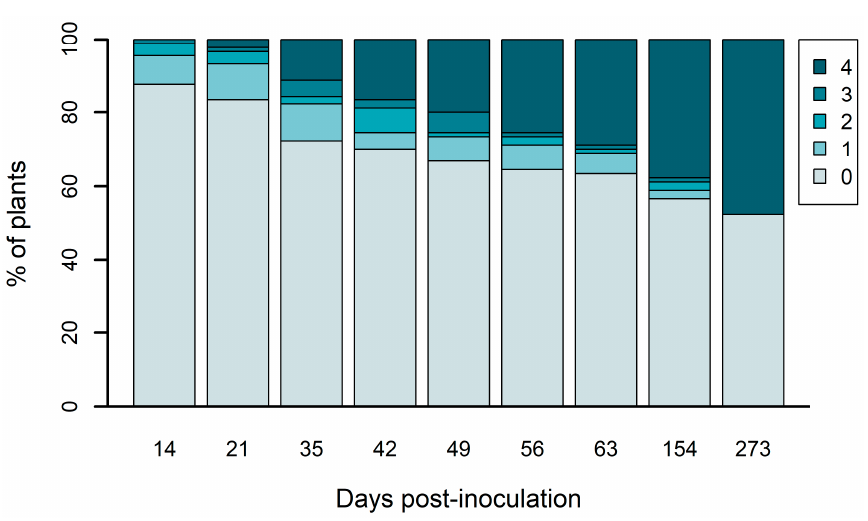
Forests 2022 , 13 , x FOR PEER REVIEW Frag. Size—size of the amplified fragment; Noncoding—SNPs in noncoding regions; Syn—synonymous SNPs; NonSyn—nonsynonymous SNPs; π —nucleotide diversity; π S —nucleotide diversity in synonymous sites; π N — nucleotide diversity in nonsynonymous sites; Hap.—number of haplotypes; Tajima’s D neutrality test [41]; SD—standard deviation. * p -value < 0.05; ** p -value < 0.01.